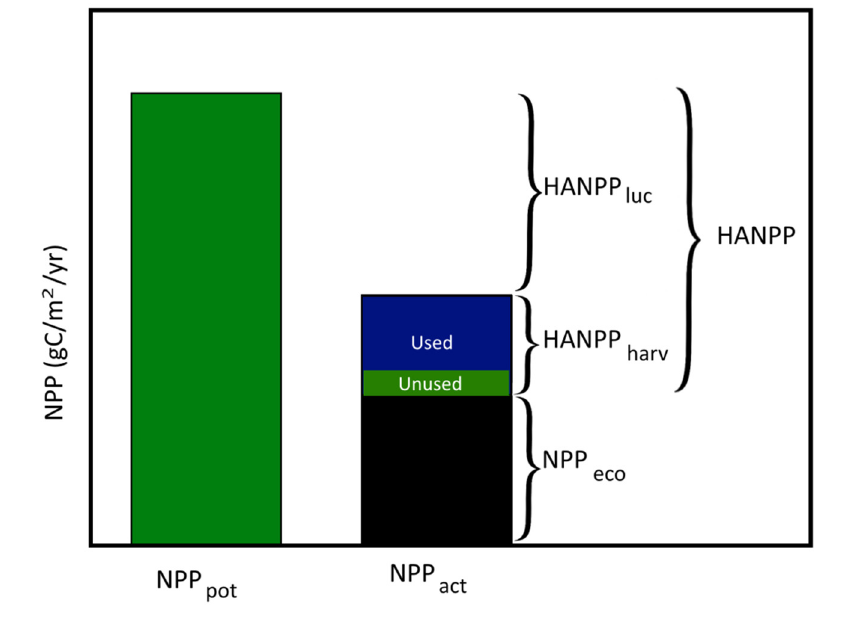
Figure 3. Conceptual model of HANPP. NPP pot is potential NPP of vegetation assuming average climate conditions, NPP act is actual NPP in the watershed, HANPP luc is NPP loss caused by land use change, HANPP harv includes both NPP harvested by humans (used) and NPP lost via herbivory (unused). NPP eco is the NPP remaining in the landscape ecosystem post-harvest. Modified from Haberl et al.